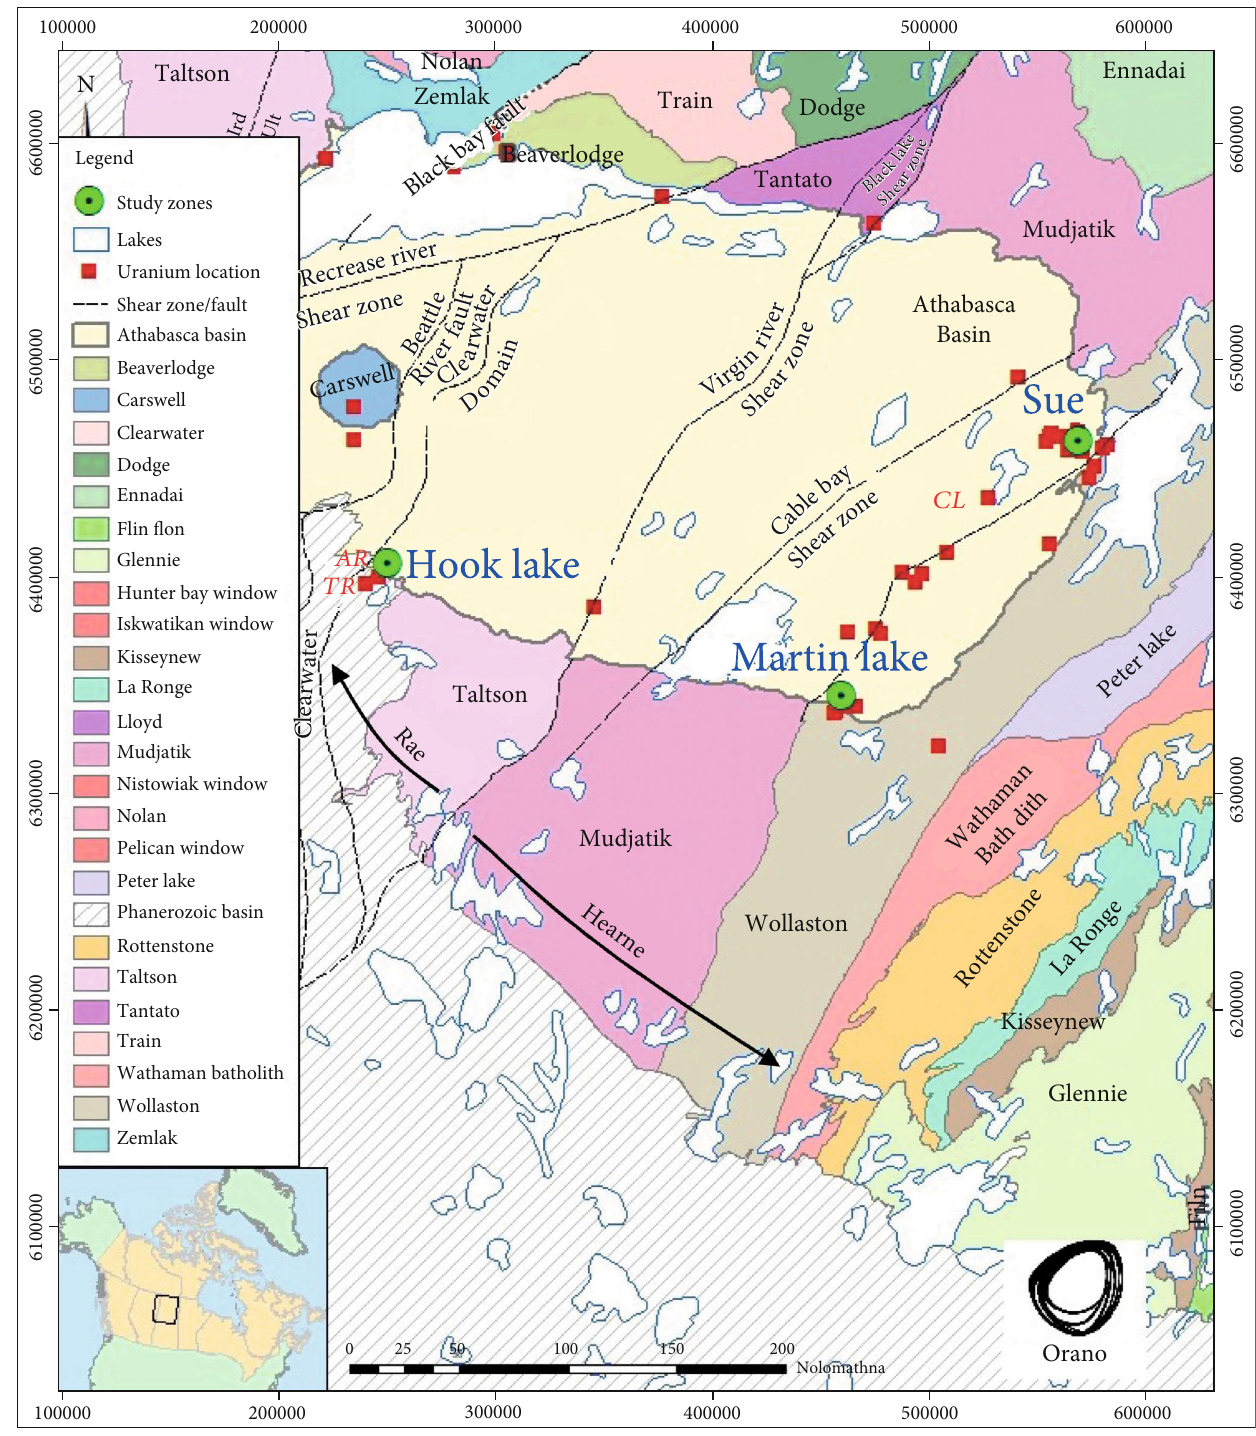
Figure 1: Regional geology and location map of the study zones (green dots): Sue deposits, Martin Lake (Tri-Island prospect) and Hook Lake Project (Spit fi re prospect). CL: Cigar Lake deposit; TR: Triple “ R ” deposit; Ar: Arrow